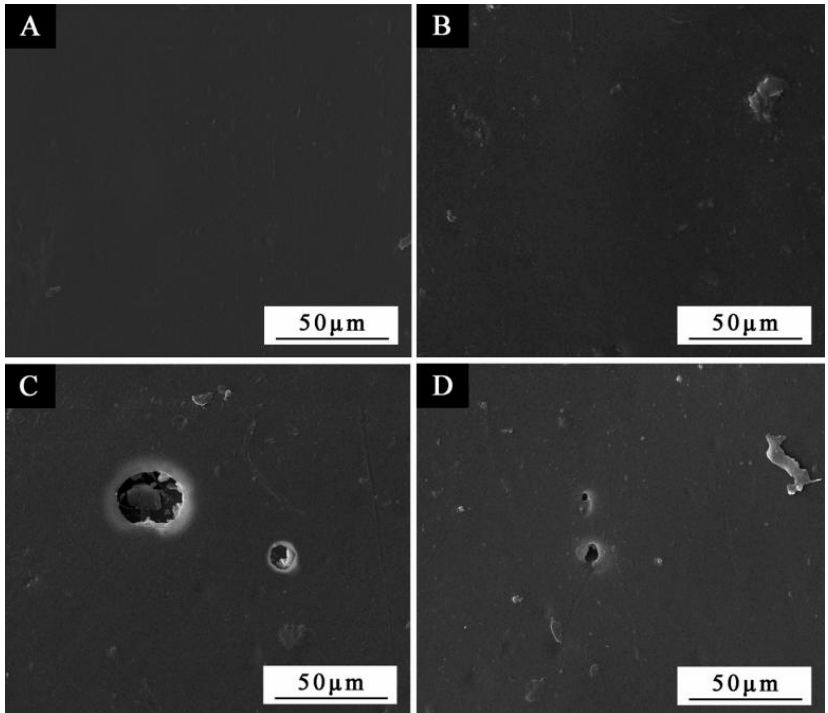
Figure 13. SEM of the paint film with and without microcapsules before and after aging in the 160 °C oven: before aging ( A ) without, ( B ) with microcapsules; after aging ( C ) without, ( D ) with microcapsules.